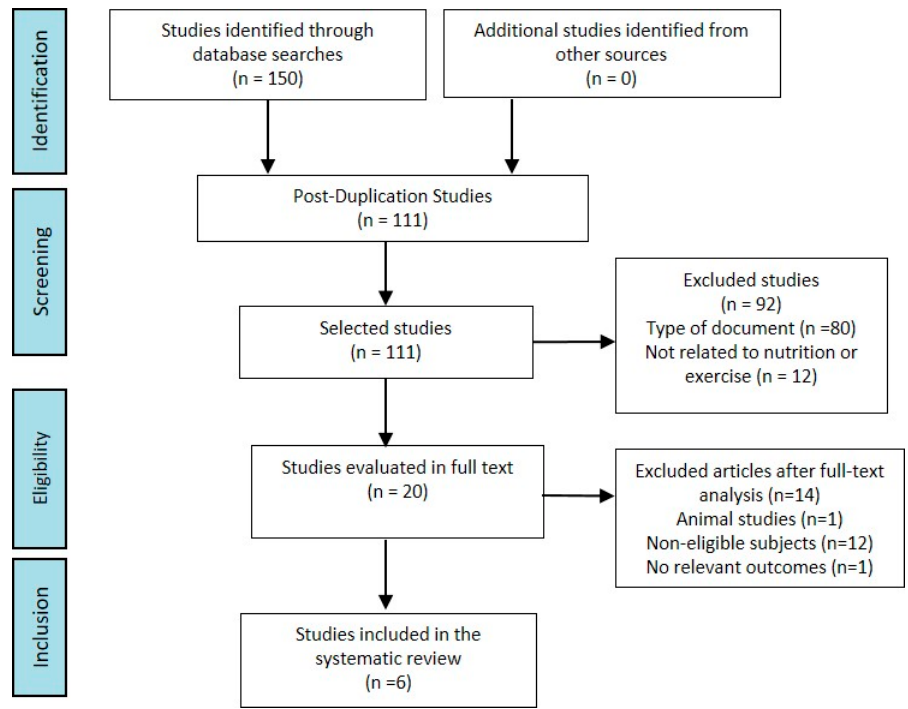
Figure 1. F low-chart of the literature search and study selection. Figure 1. Flow-chart of the literature search and study